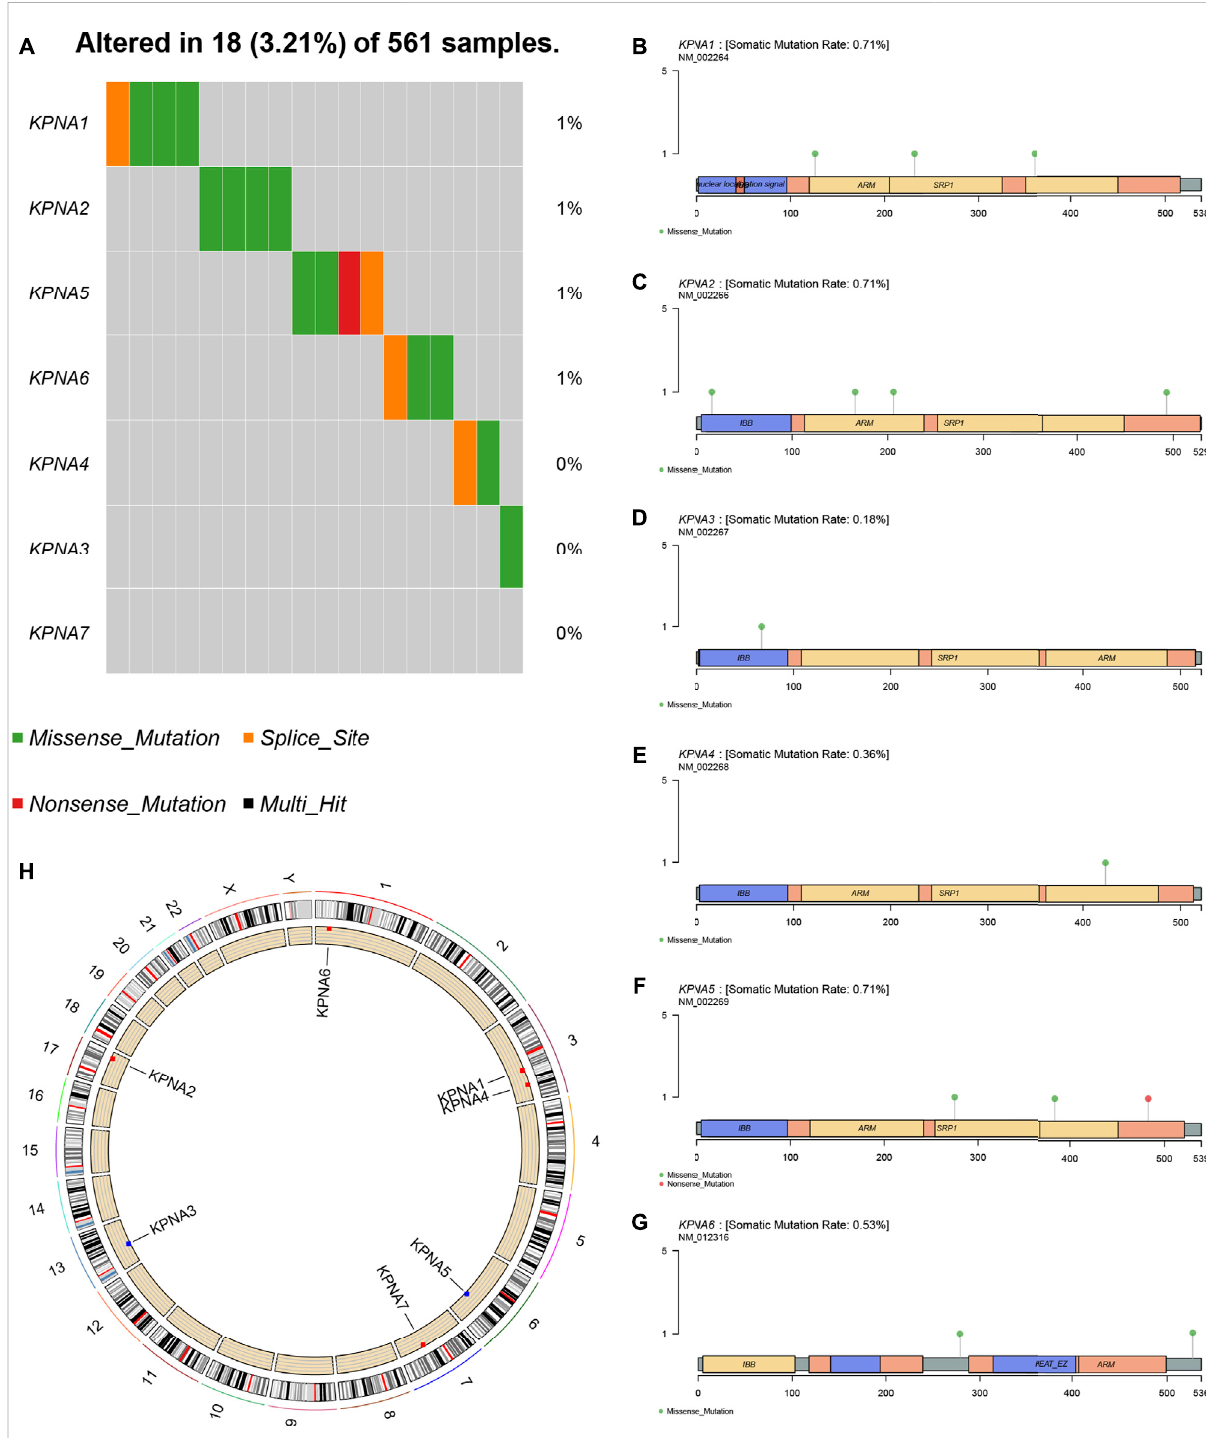
FIGURE 2 Mutations and copy number variations (CNV) of the KPNA family (A) Mutation frequency of the KPNA family (B – G) Mutated sites of the KPNA family (H) Copy number alterations of the KPNA family; red dots indicate that ampli fi cations are greater than deletions while blue dots indicate that deletions are greater than ampli fi